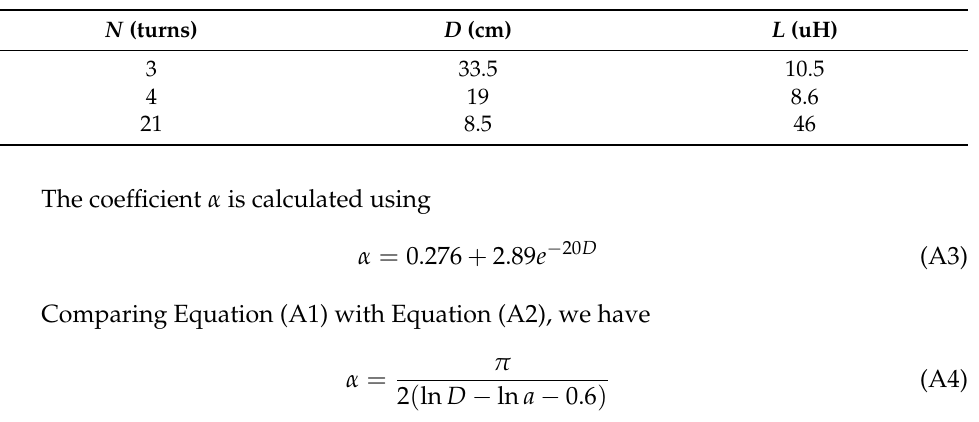
Table A1. Measured three inductors with different arrangements.